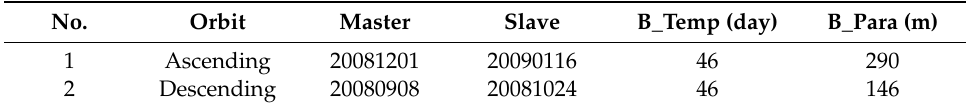
Table 1. Parameters of the formed ALOS PALSAR image pairs. B_para and B_temp represent the spatial baseline and time interval between the two acquisitions, respectively. No.